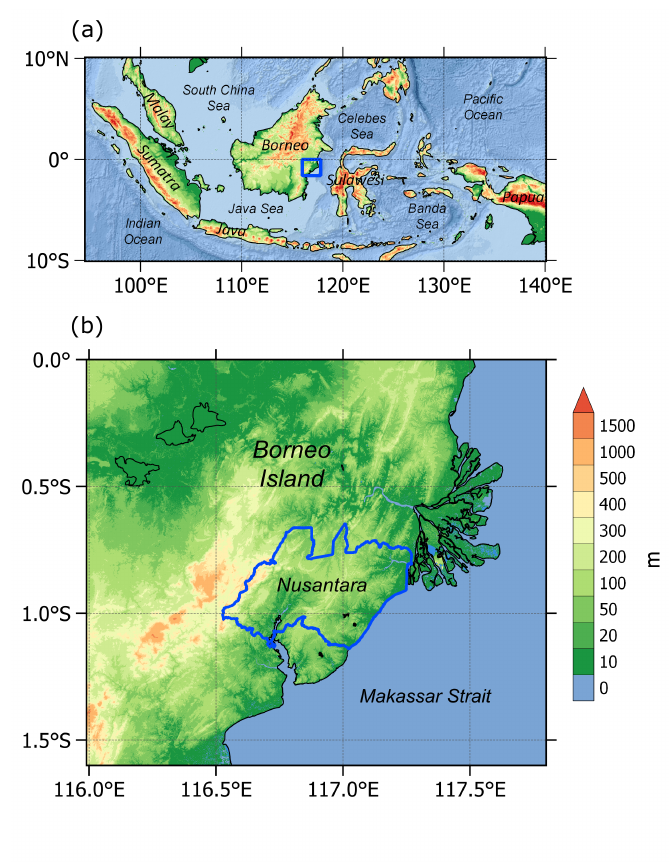
Figure 1. Topography map of ( a ) the study area (blue rectangle) located in the middle of the Maritime Continent on the eastern Borneo Island ( b ) the administrative borderline of Nusantara (blue